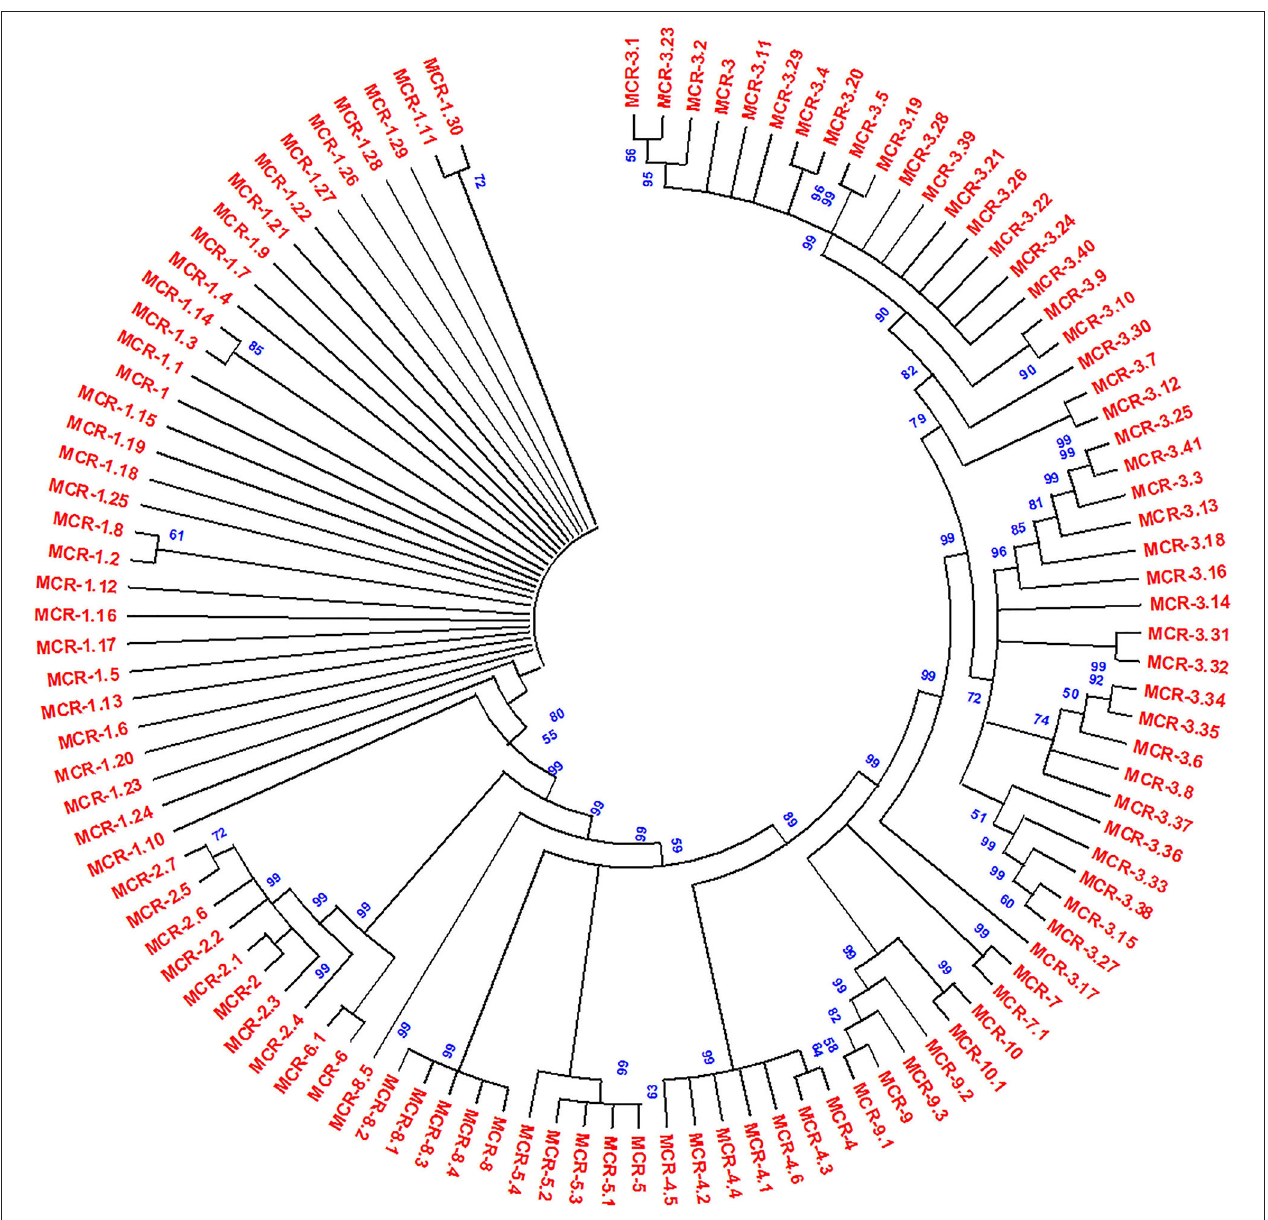
FIGURE 4 | Phylogenetic tree of mcr gene variants, constructed by neighbor-joining method (bootstrap analysis with 500 replicates). All the proteins used for the phylogenetic tree were members of the PEA lipid A transferase family. Multiple sequence alignment was conducted using Clustal W, and resultant output was generated with Mega